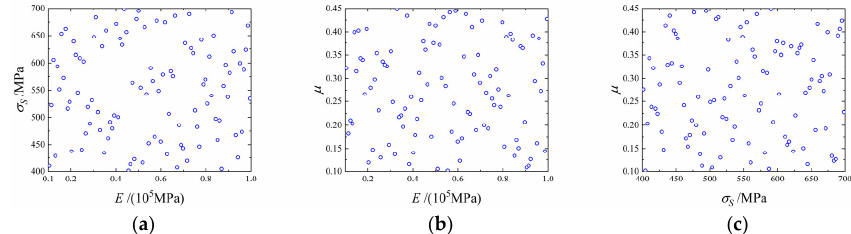
Figure 7. Sampling results of the first group of three variables: ( a ) E − σ